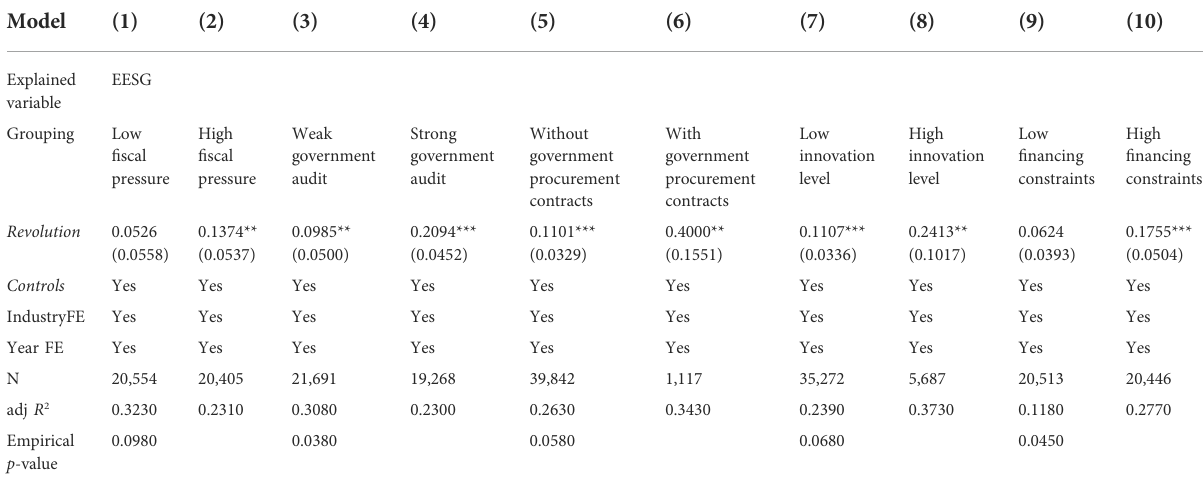
TABLE 6 PBB and enterprise environment in ESG (Heterogeneity Analysis).